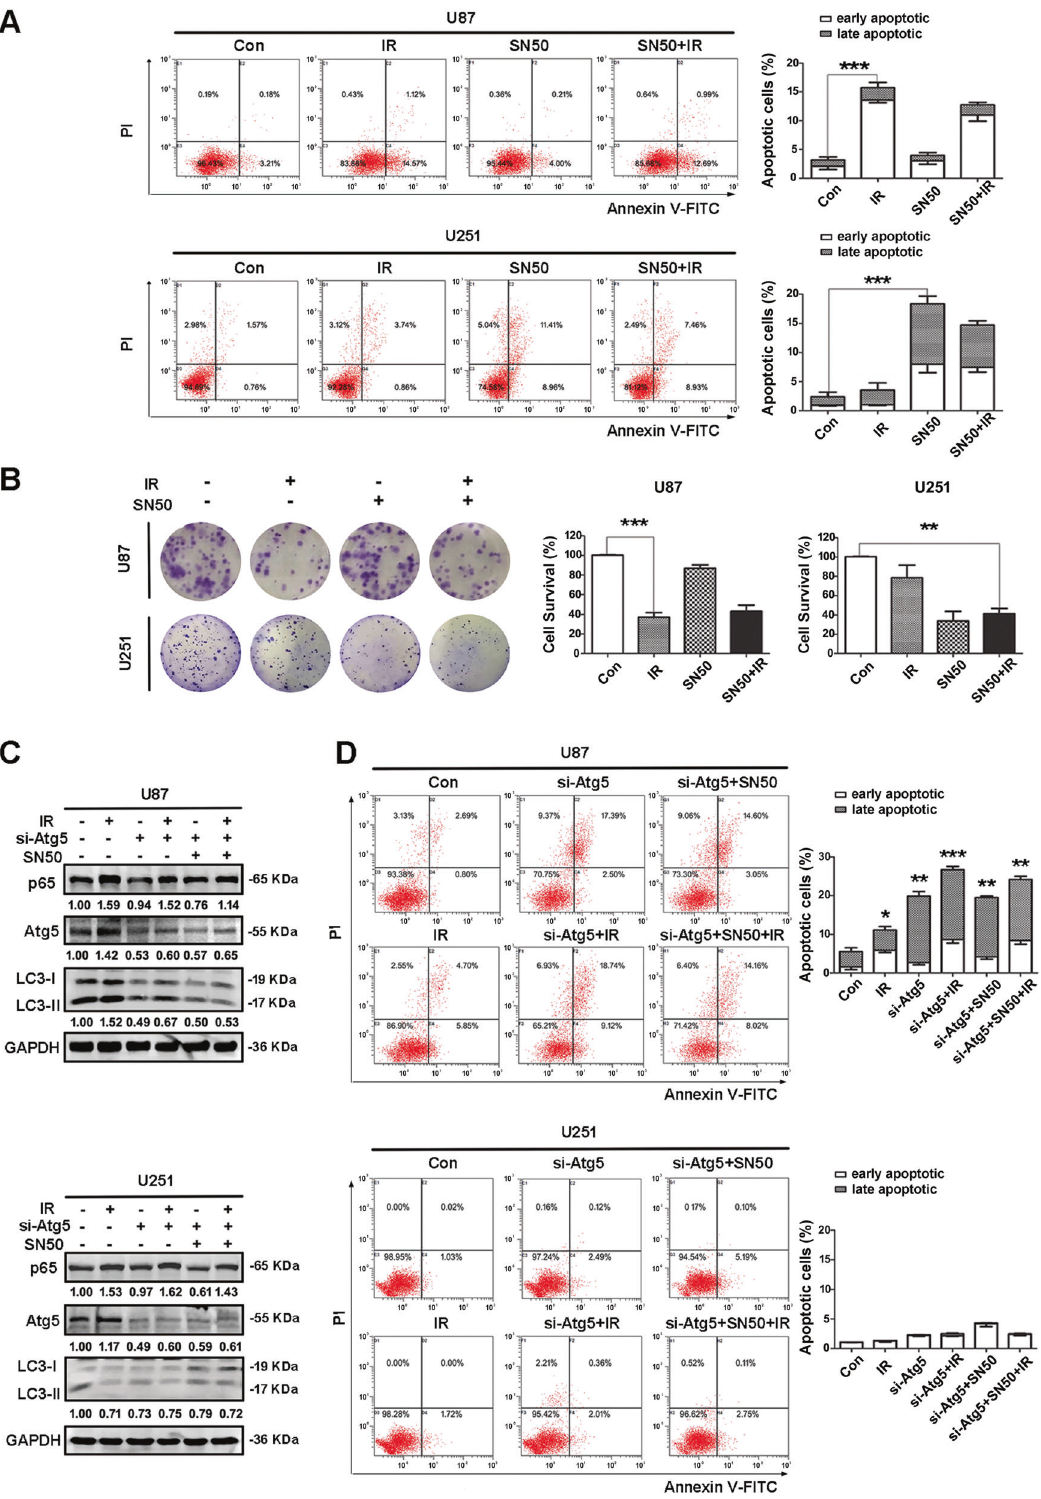
Fig. 5 Evidence for NF- κ B as a negative regulator of autophagy in mut-p53 cells after IR. A U87 and U251 cells were treated according to different requirements, then Annexin V-FITC/PI double dyes were used to stain the cells and determine cell apoptosis 24 h later in each group. B U87 and U251 cells were treated as required, and colony-formation assay detected the cell survival. C Inhibiting the expression of autophagy-related protein Atg5 by siRNA, then western blotting was used to analyze the changes of p65, Atg5, and LC3 proteins in each group. D Inhibiting the expression of autophagy-related protein Atg5 by siRNA, then Annexin V-FITC/PI double dyes were used to stain the cells and determine cell apoptosis 24 h later in each group ( * P < 0.05, ** P < 0.01, *** P < 0.001 vs. control). Table